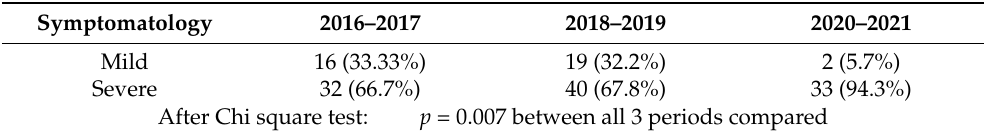
Table 1. Presence of severe symptomatology.